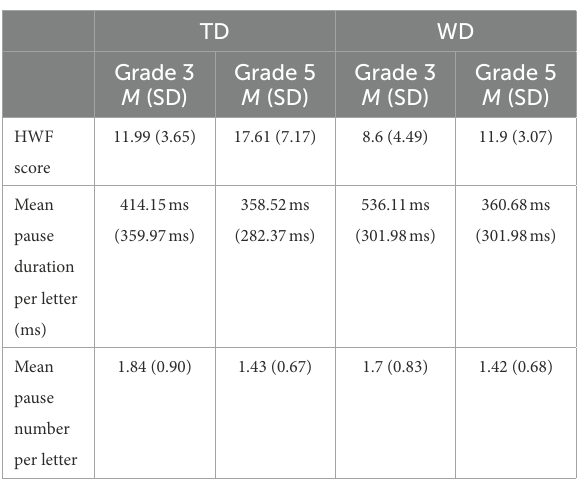
TABLE 3 Descriptive statistics of HWF score, pause number and duration by group and